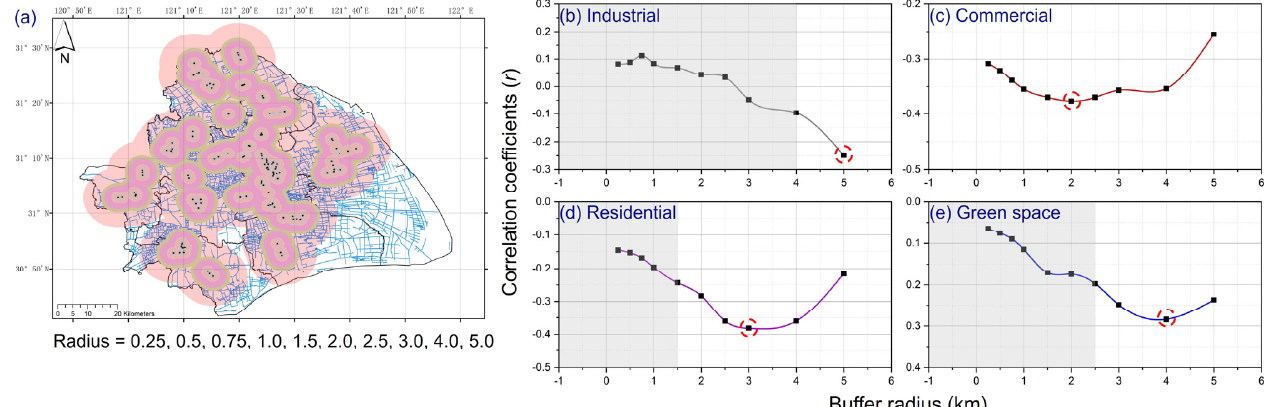
Figure 4. Quantitative evaluations on the maximum extent each land-use type influence the sum- mertime water quality index (WQI d ). We extracted the kernel density of each land-use type using the zonal statistics for each buffer radius. Pearson’s correlation coefficients were applied to evaluate the results. ( a ) The buffer radius that was set up for the spatial analysis, in ( b – e ), red dotted circles indicate the maximum extent of influence, and grey shaded areas express non-significance ( p < 0.05).